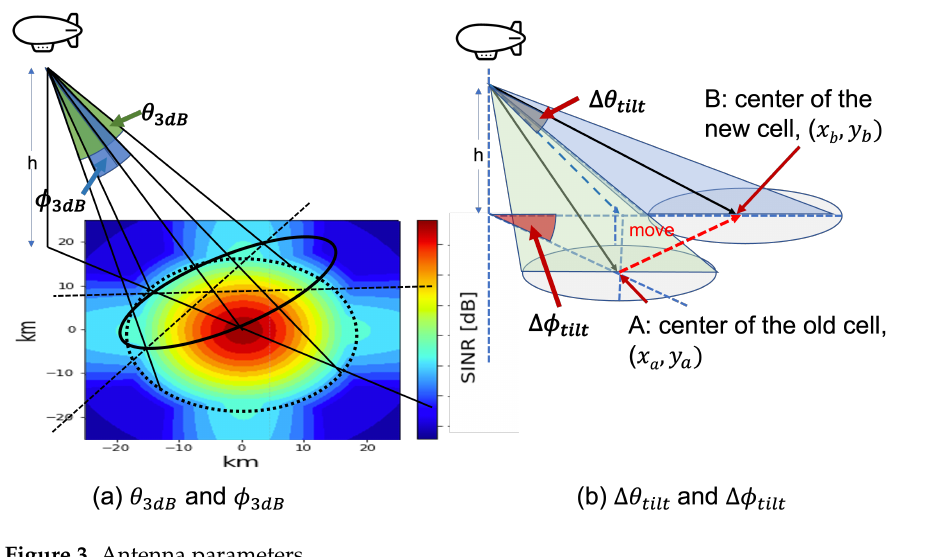
Figure 3. Antenna parameters.